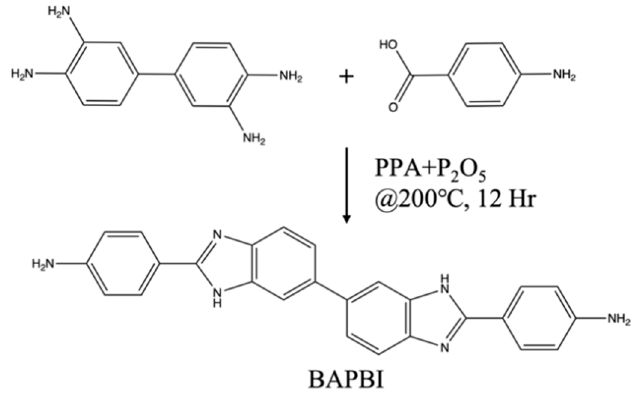
Figure 1. Schematic diagram of BAPBI synthesis.